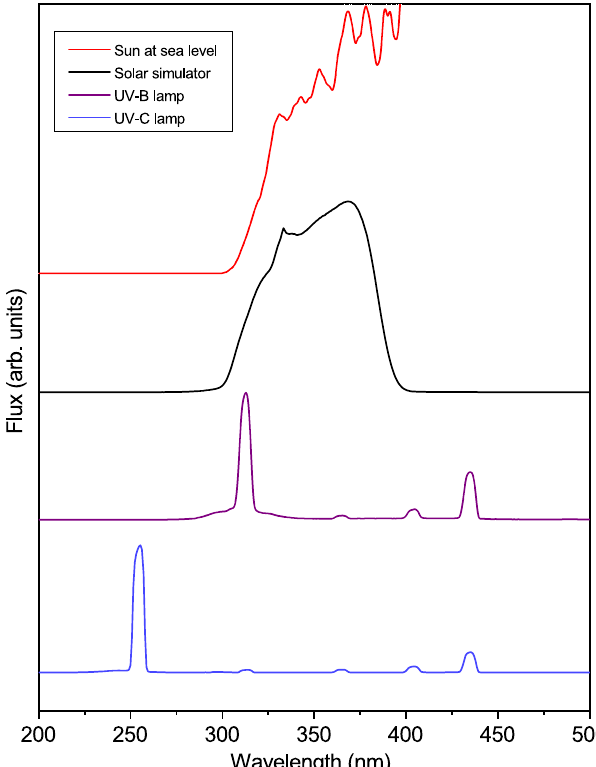
Figure 2. Comparison of the spectra of the lamps used for the experiments. From top to bottom (in arbitrary flux unities): the Sun over Earth’s surface (ASTM G173-03, smoothed), the Oriel Sol-UV-2 solar simulator, and the UV-B and UV-C lamps, measured with an Ocean Optics QE65000 spectrometer. It is apparent that the commonly used UV-B and UV-C narrow-band lamps largely differ from the UV in the real environment.